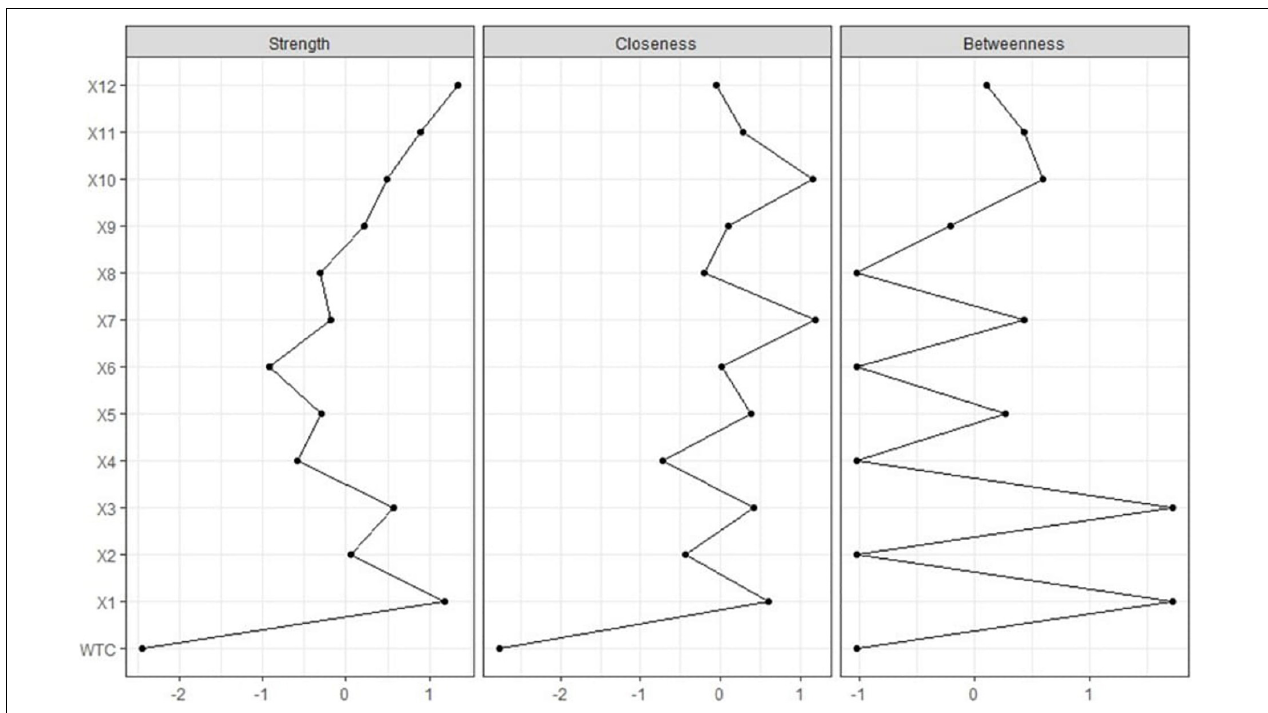
FIGURE 5 | Centrality indices are shown as standardized z-scores.